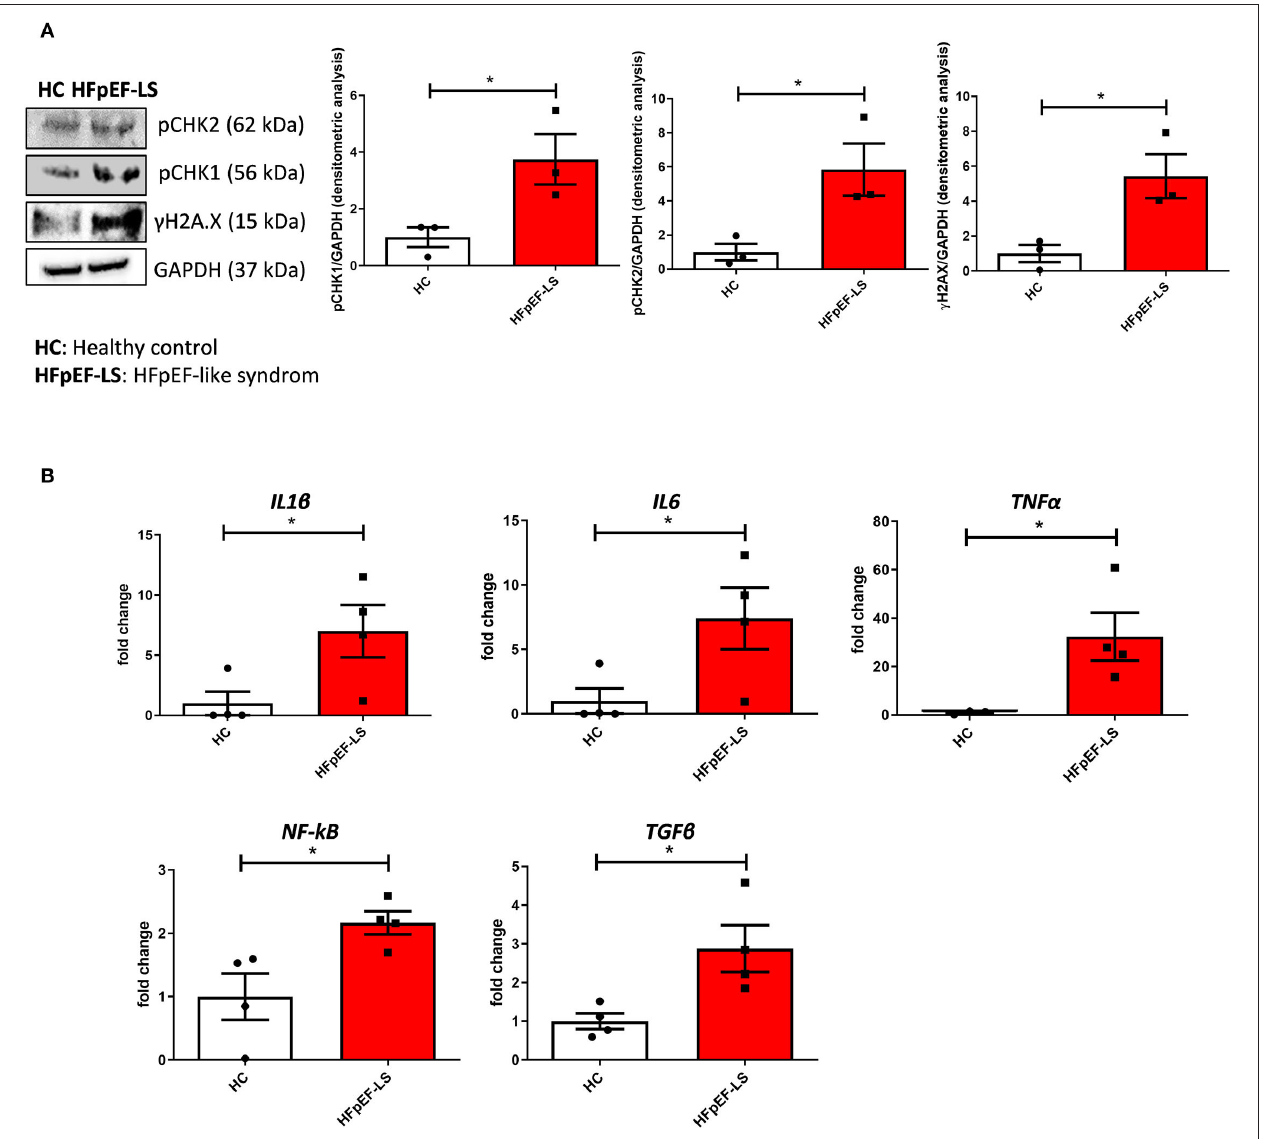
FIGURE 2 | C-MSCs from patients with HFpEF-like syndrome show activated DDR and increased expression of pro-inflammatory and pro-fibrotic mediators compared to those from HC. (A) Left panel: Western blot analysis of anti- γ H2AX, anti-pCHK1, and pCHK2 in HFpEF and HC C-MSC. The housekeeping GAPDH is shown for normalization. Right panels: densitometric analyses of γ H2AX, pCHK1, and pCHK2 levels, normalized on GAPDH. * p < 0.05. (B) Expression of inflammation- ( IL1 β , IL6 , TNF α , NF-kB ) and fibrosis-associated genes ( TGF β ) in total RNA extracts of C-MSC from HC donors and patients with HFpEF. GAPDH was used as a housekeeping gene, and qRT-PCR data are presented as the fold change of target gene expression with respect to HC C-MSC. * p < 0.05.